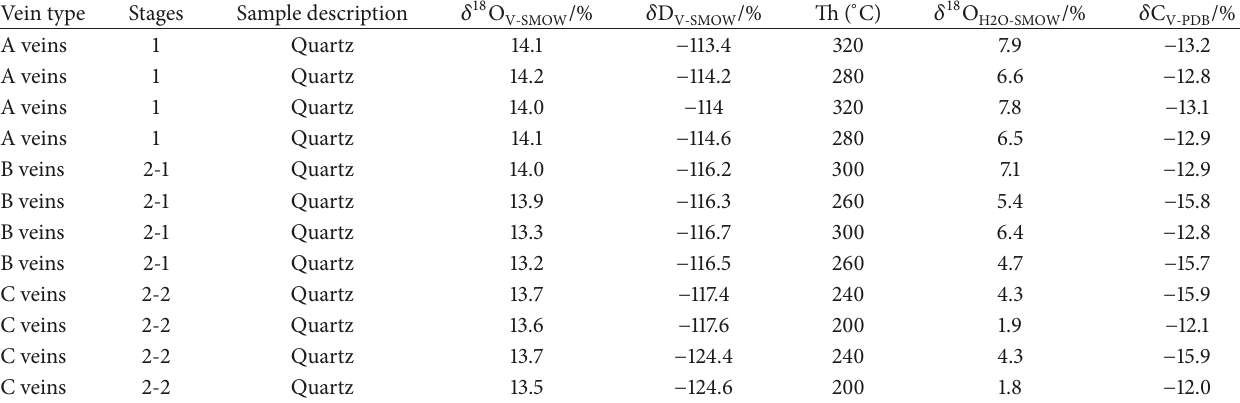
Table 2: Oxygen, hydrogen, and carbon isotope data for hydrothermal quartz of Stages 1 - 2 , Bairendaba Ag–Zn–Pb deposit.